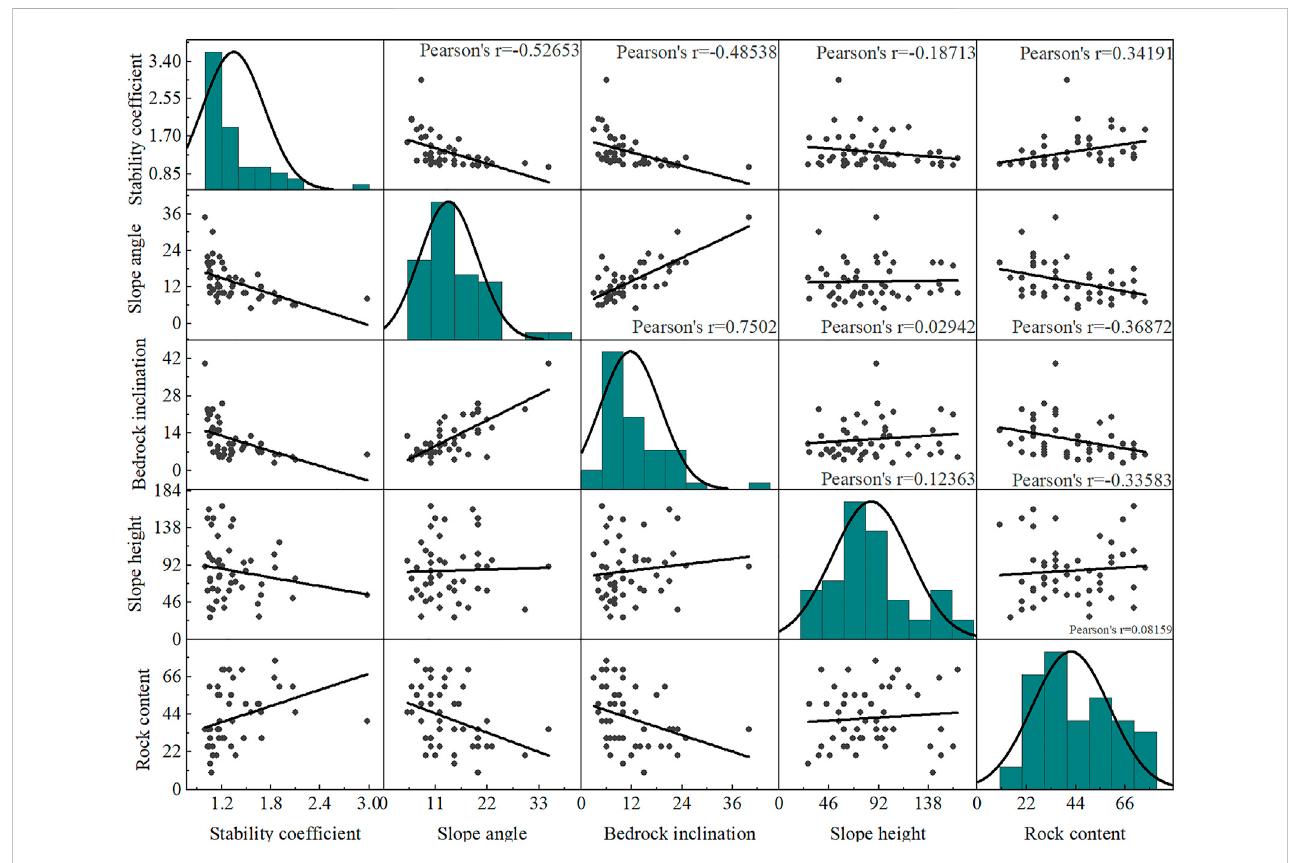
FIGURE 6 Correlation and statistical distribution of parameters related to soil-rock mixture